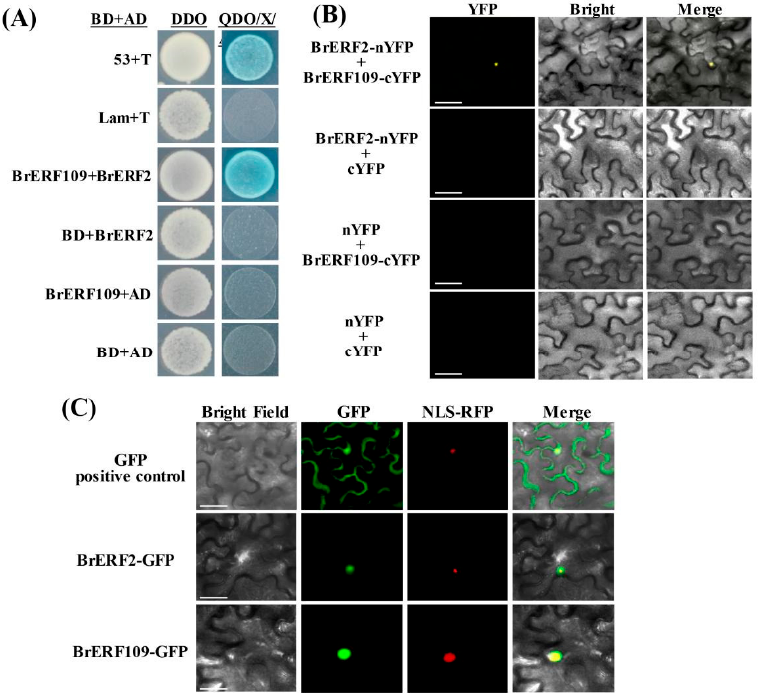
Figure 7. BrERF2 interacts with BrERF109. ( A ), The interaction between BrERF2 and BrERF109 was analyzed by Y2H assay. ( B ), BiFC analysis showed the interaction of BrERF2 and BrERF109 in vivo. Bar, 25 µ m. ( C ), Subcellular localization of BrERF2 and BrERF109 in tobacco leaves. Bars, 25 µ m. Each protein-protein interaction was proved by three independent experiments.